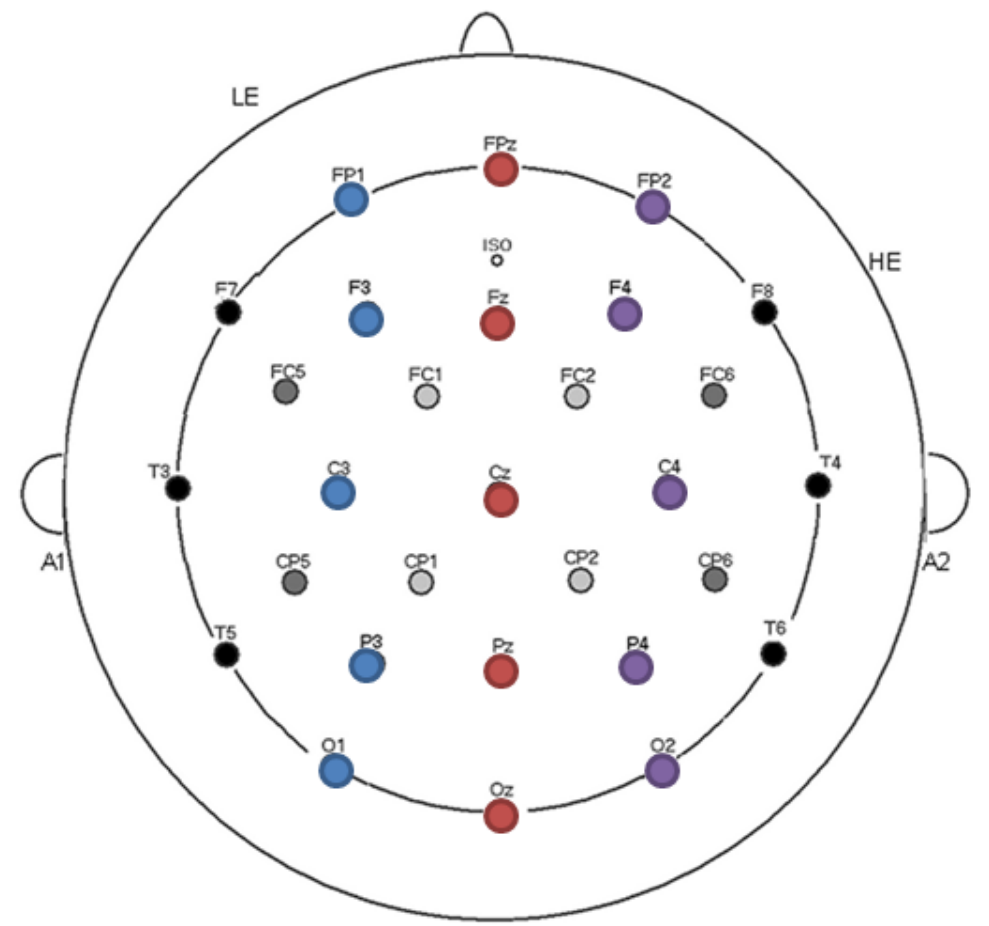
Figure 3. Electrode montage and electrode sites used for analyses.